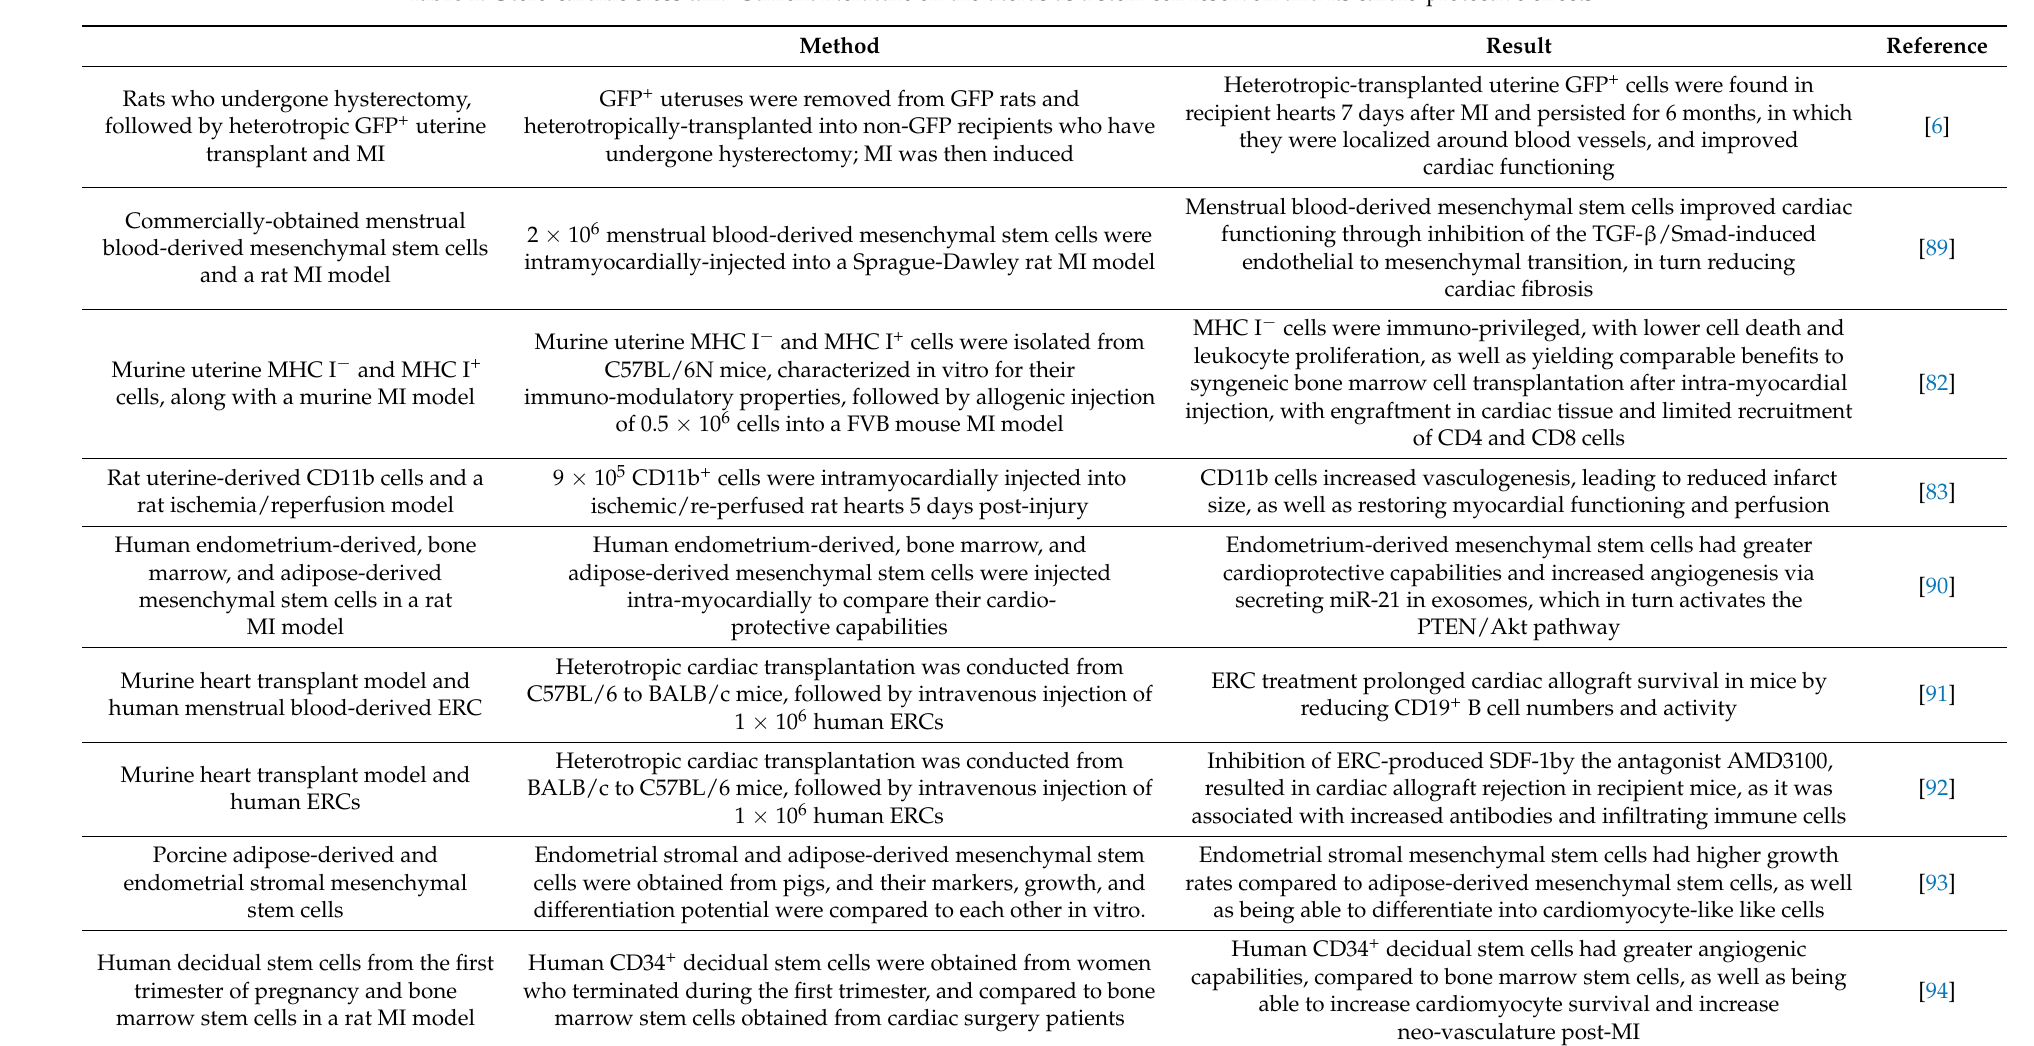
Table 1. Utero-cardiac cross talk: Current literature on the uterus as a stem cell reservoir and its cardio-protective